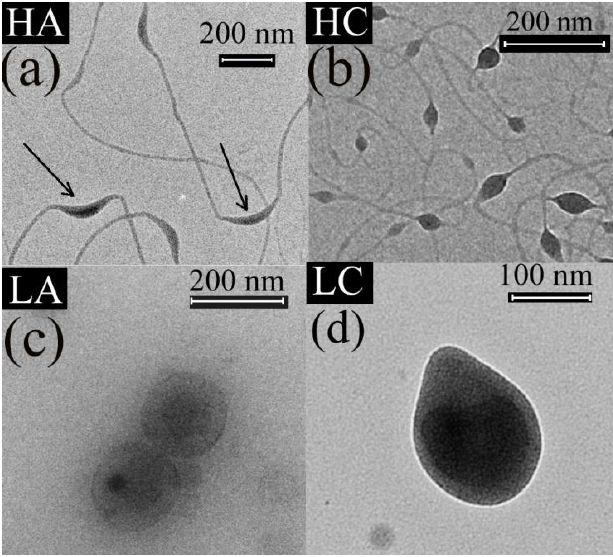
Figure 2. Transmission electron microscope (TEM) images of the studied samples: ( a ) HA; ( b ) HC; ( c ) LA; and ( d ) LC samples.